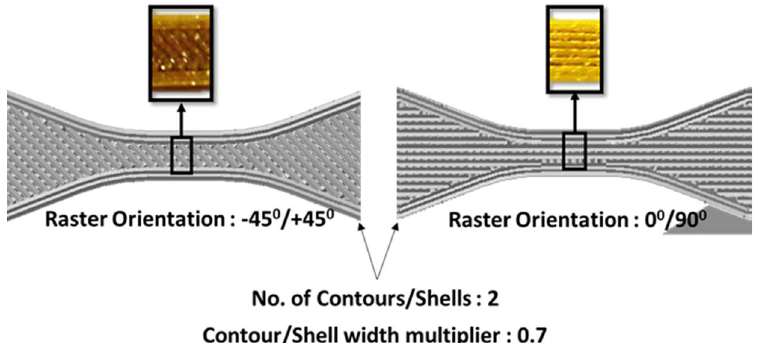
Figure 3. Different raster angle as a result of printing a thermoplastic polyurethane part in different